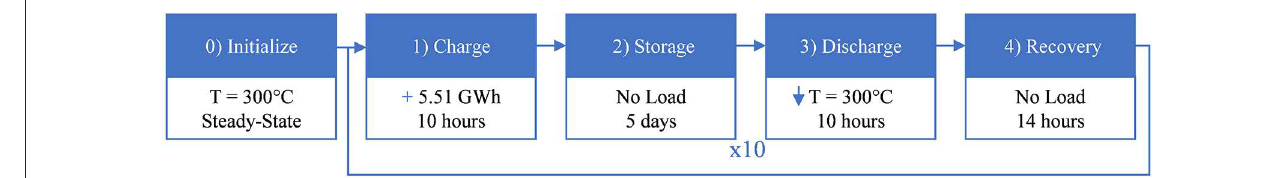
FIGURE 3 | Diagram of how operating conditions were modeled with an initialization step and four-step cycles. The primary thermal effect applied to the particle domain and the length of the operating step are listed. All steps include the constant HTCs on the respective exterior